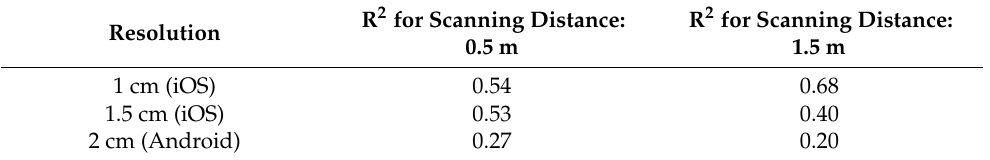
Table 3. R 2 values obtained by linear regression between sample albedo and surface variation values.